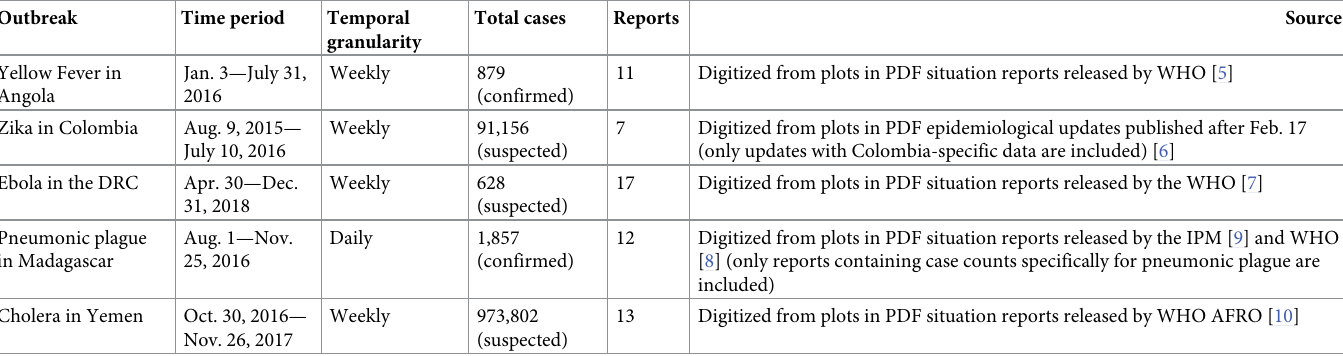
Table 3. Epidemiological data sources.